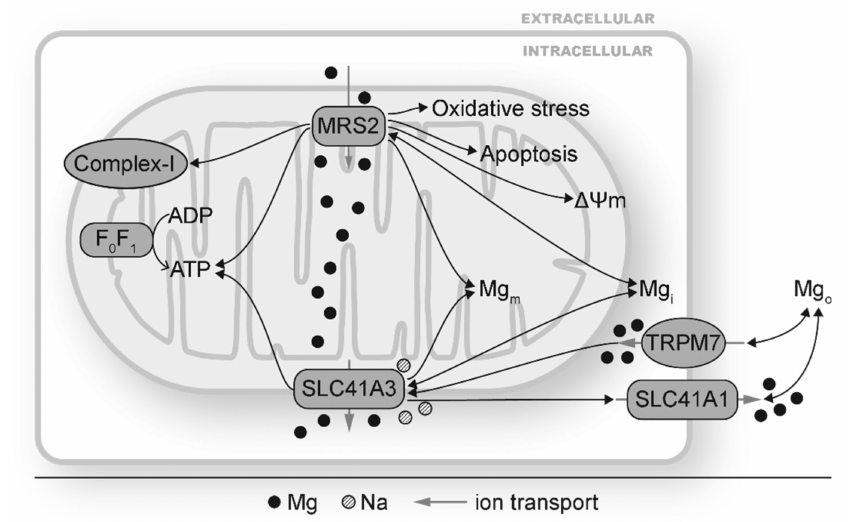
Figure 2. Mitochondrial Mg transporters MRS2 and SLC41A3 mediate mitochondrial and cellular changes by modulating mitochondrial Mg homeostasis. MRS2 and SLC41A3 carry out mitochondrial Mg (Mg m ) influx and e ffl ux, respectively. Changes in MRS2 have shown to alter Mg m and a ff ect complex I, ATP production, mitochondrial membrane depolarization ( ∆Ψ m ), intracellular Mg (Mg i ), and cellular oxidative stress and apoptosis. Changes in SLC41A3 has been reported under hypomagnesemia and TRPM7 depletion. SLC41A3 impacts ATP production, expression of other Mg transporters such SLC41A1. The double-headed black arrows indicate that changes in Mg transporters can result in and from disturbed Mg